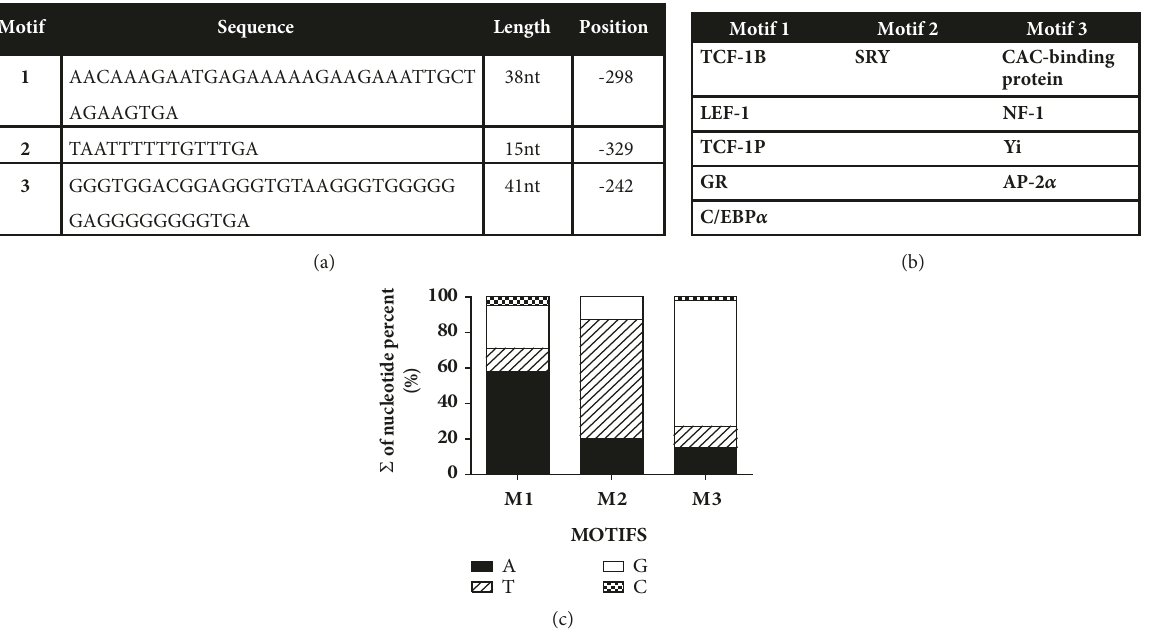
Figure 9: In silico analysis obtained by bioinformatic on line tools. The motifs (M) sequences in 5 󸀠 untranslated regions obtained by MEME program indicate the length and position regarding the transcription start signal (a). Transcription factors found through TESS database in motifs (b). Percentage of nucleotide presence on these motifs